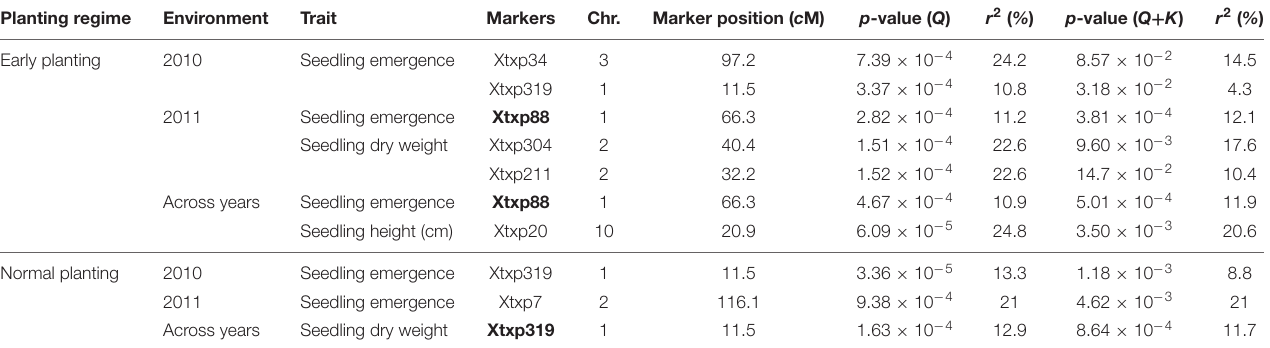
FIGURE 4 | Scatterplots of estimates of r 2 of SSR marker pairs for (A) whole genome, (B) chromosome 1, and (C) chromosome 2, showing LD decays as measured by r 2 against genetic distance ( c M). The decay curves were plotted with log. ( r 2 ) values using curvilinear regression in SPSS software. TABLE 7 | Significant marker-trait associations identified under early and normal planting regimes using both general linear model (GLM) and MLM under two environments and combined across environments. Planting regime Environment Trait Markers Chr. Marker position ( c